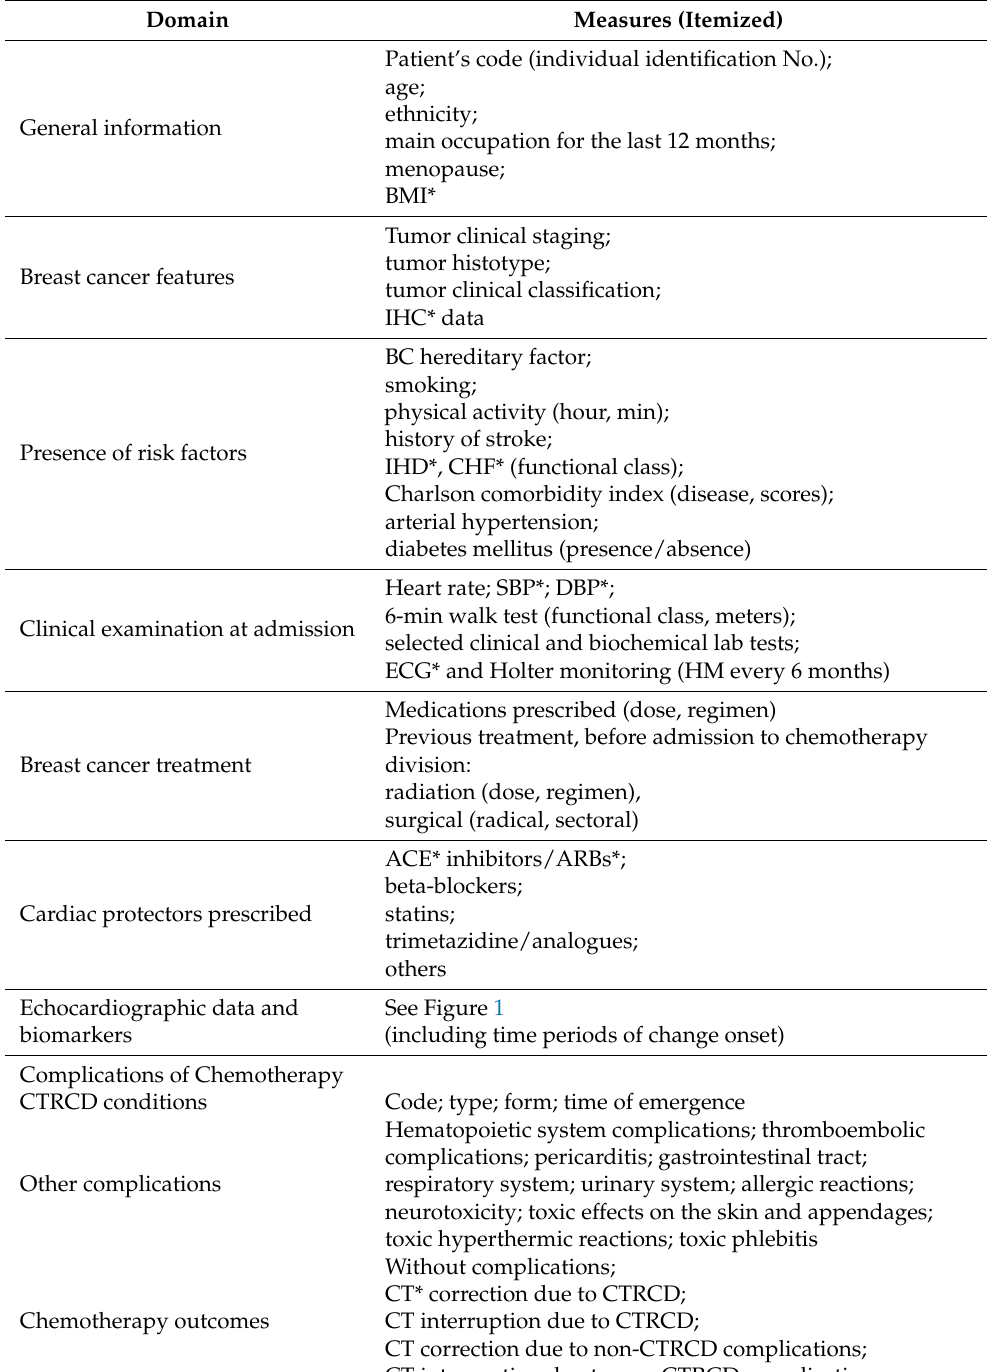
Table 1. Type of data subject to collection during